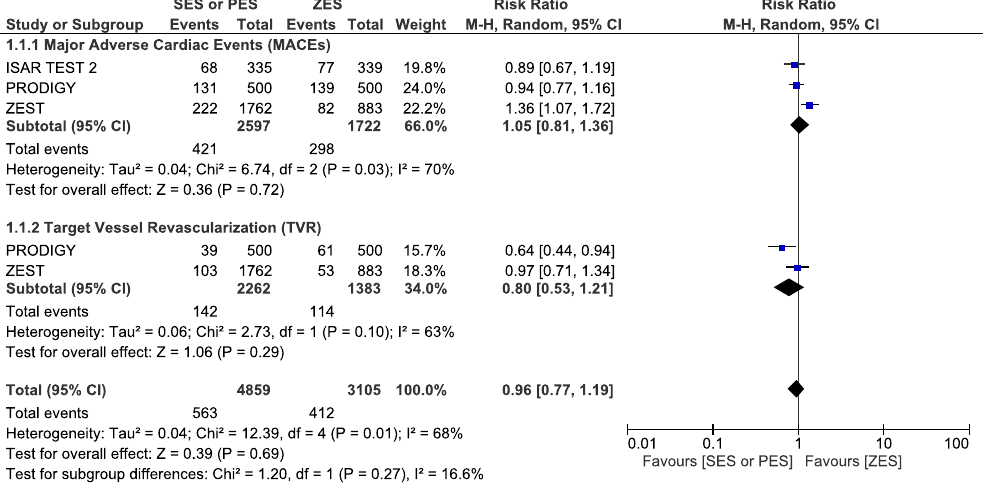
Figure 10. Adverse clinical outcomes which were associated with ZES versus SES or PES at 2-year follow-up (part